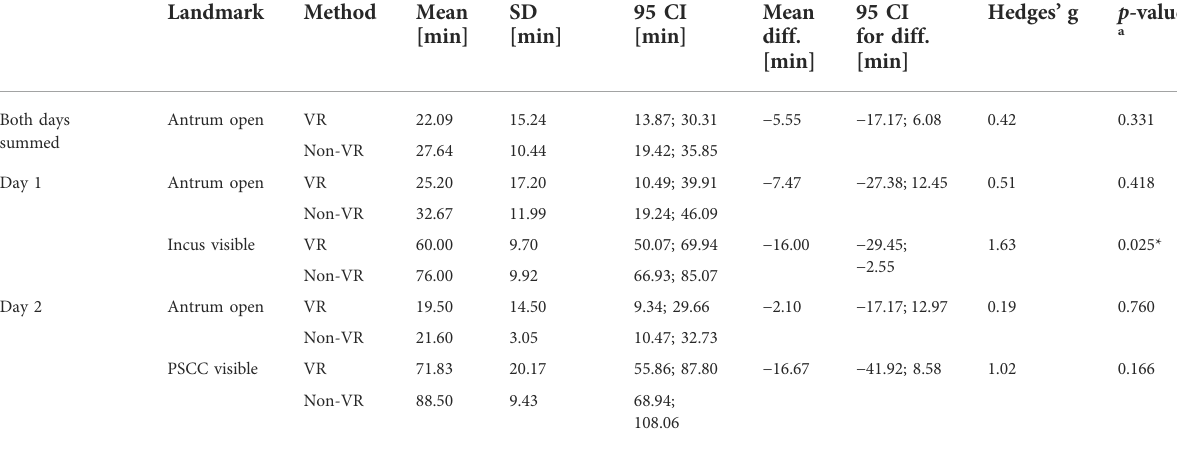
TABLE 2 Time used for landmark dissection (surgical time) in both groups.